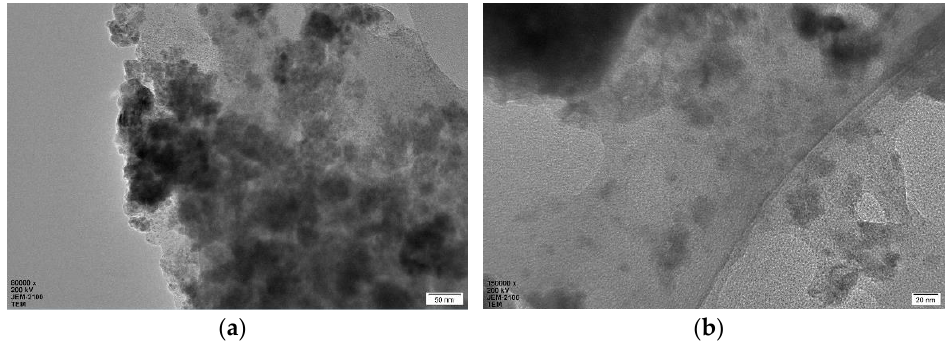
Figure 3. TEM images of ( a ) CP@Cu at 60 nm and ( b ) CP@Cu at 20 nm.